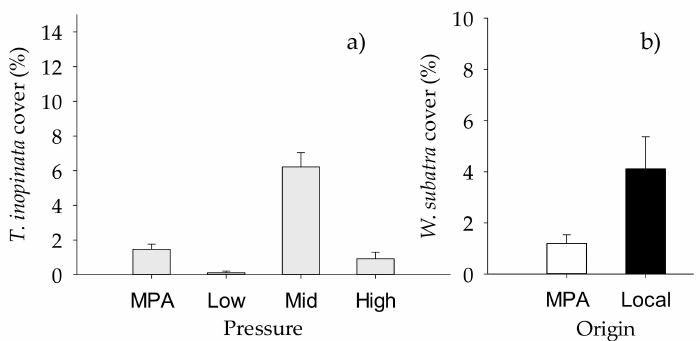
Figure 5. Mean ( + SE) percentage cover of NIS ( a ) Tricellaria inopinata , showing di ff erences between “Pressure” ( n = 20, n = 10 for MPA), and ( b ) Watersipora subatra , showing di ff erences between “Origin of biofilm” ( n = 30 for local, n = 40 for MPA) ( n = 10). White bars, MPA biofilm; black bars, local biofilm.